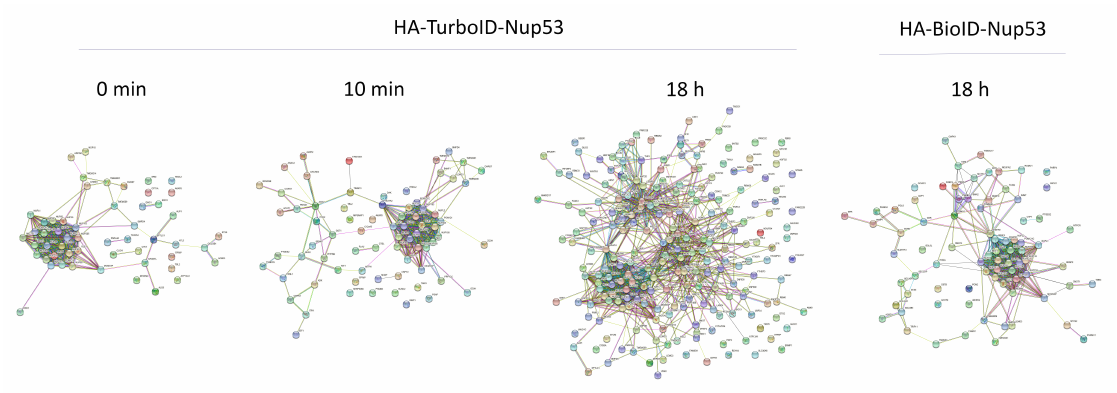
Figure 7. Major candidates for TurboID-Nup53 are biotinylated prior to biotin supplementation. Figure 2. ( a ) Schematic illustration of the procedures of the micromolding process for fabricating the PLLA microneedles. ( b ) The dimensions of the fabricated PLLA microneedles.